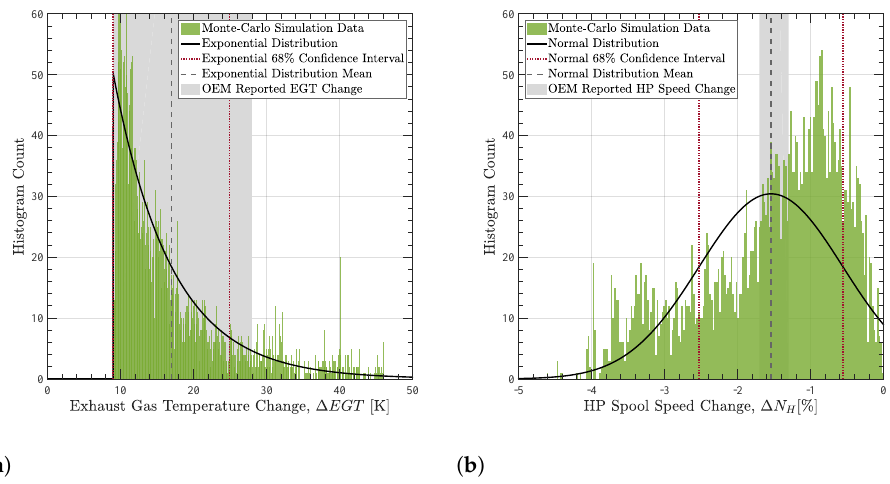
Figure 7. Model-predicted change in exhaust gas temperature ( a ) and high-pressure spool speed ( b ) for the Mount Soputan encounter event, with exponential and normal distributions respectively fit to the data and a comparison between the mean performance change predicted by the model and the range observed for the four engines involved in the